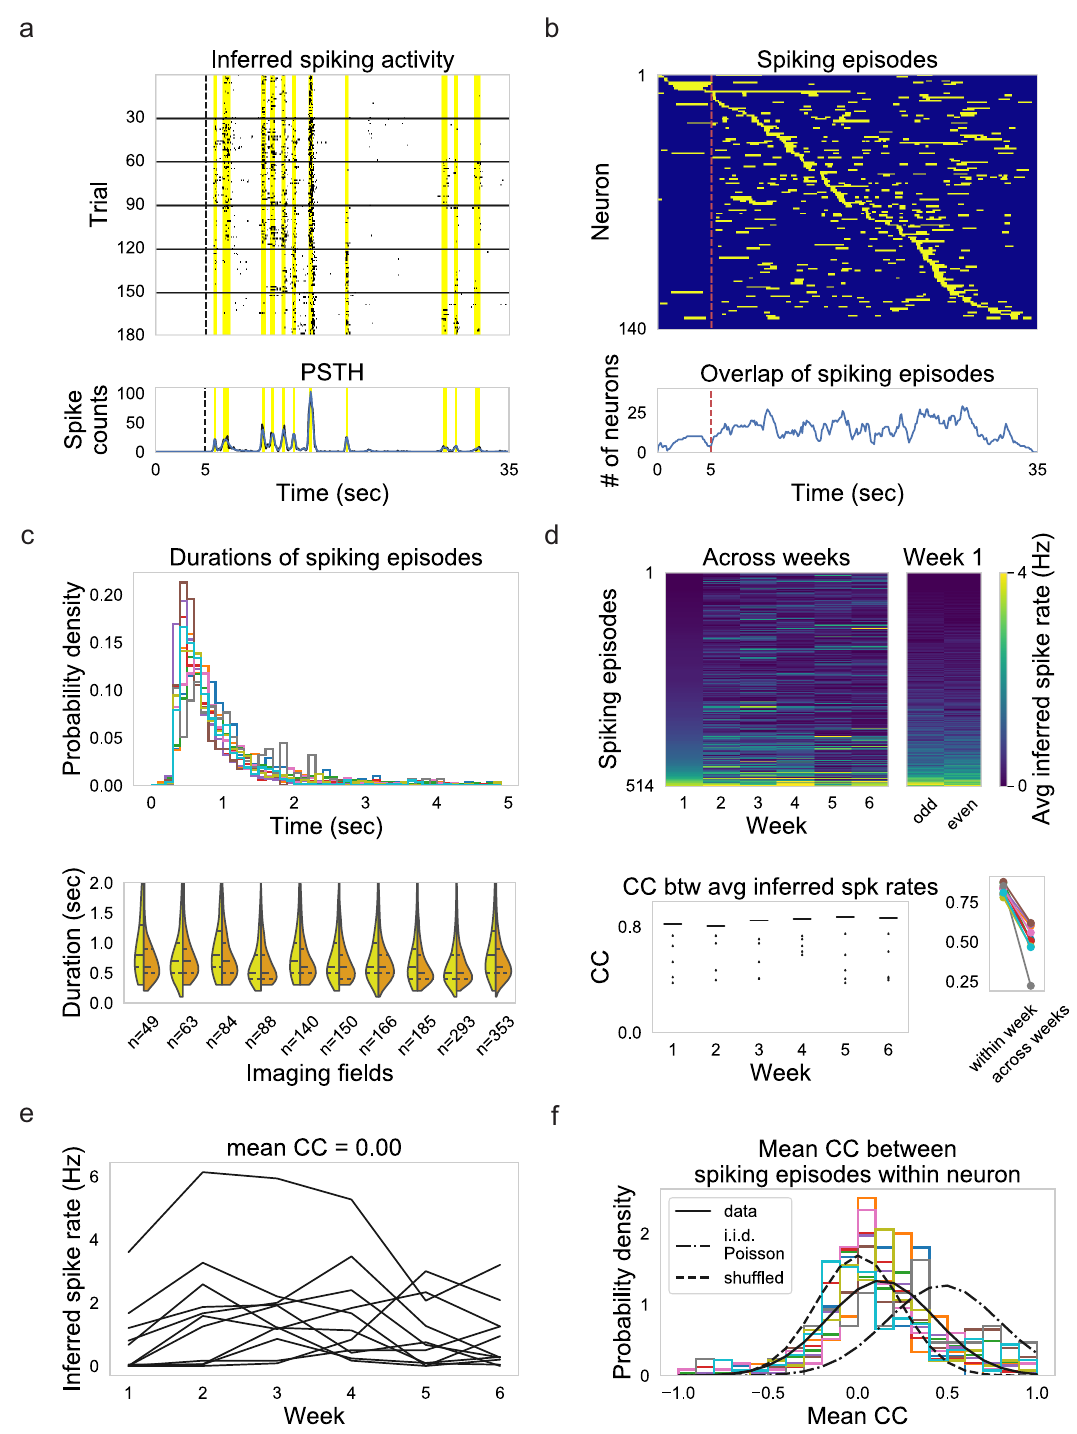
diverse variation of the trial factor values (Fig. 3c, right) re fl ected the diverse gain variability of episodic activity (Fig. 2d), even for any given neuron (Fig. 2e,